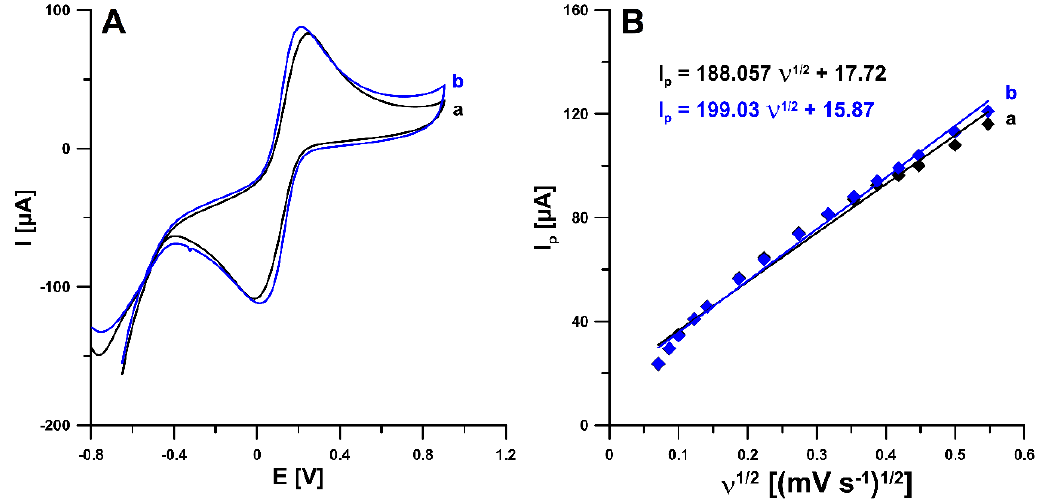
Figure 2. ( A ) Cyclic voltammograms of 5.0 mM K 3 [Fe(CN) 6 ] and 0.1 M KCl at the SPCE (a) and SPCE/SDS (b) ( ν of 150 mV/s). ( B ) The relationship between I p and ν 1/2 for ν from 5 to 300 mV/s.